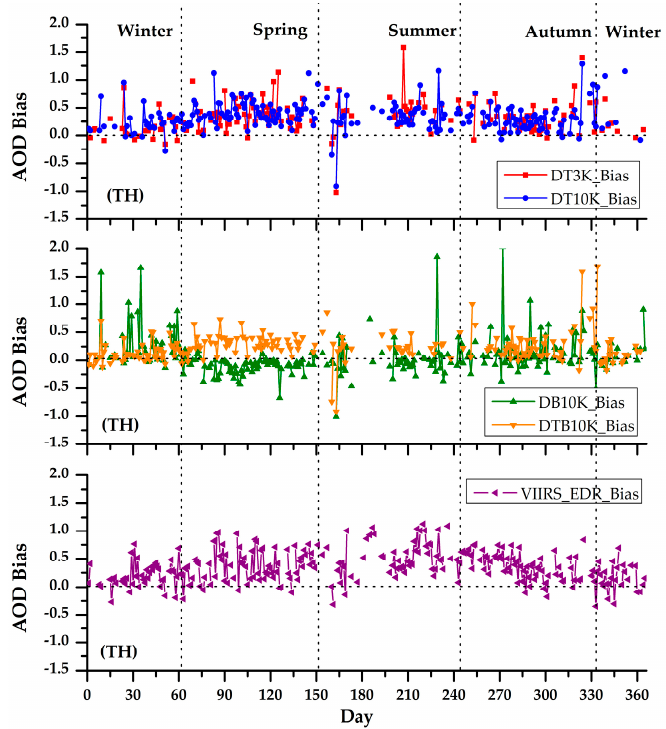
Figure 9. Seasonal variation of aqua-MODIS C6 and VIIRS_EDR AOD retrieval biases (QF = 3) only during CE318 AOD observations >0.4 at TH site. Notice that y-axis refers to the multi-year daily mean AOD bias values for the period of 2 May 2012–31 December 2016.